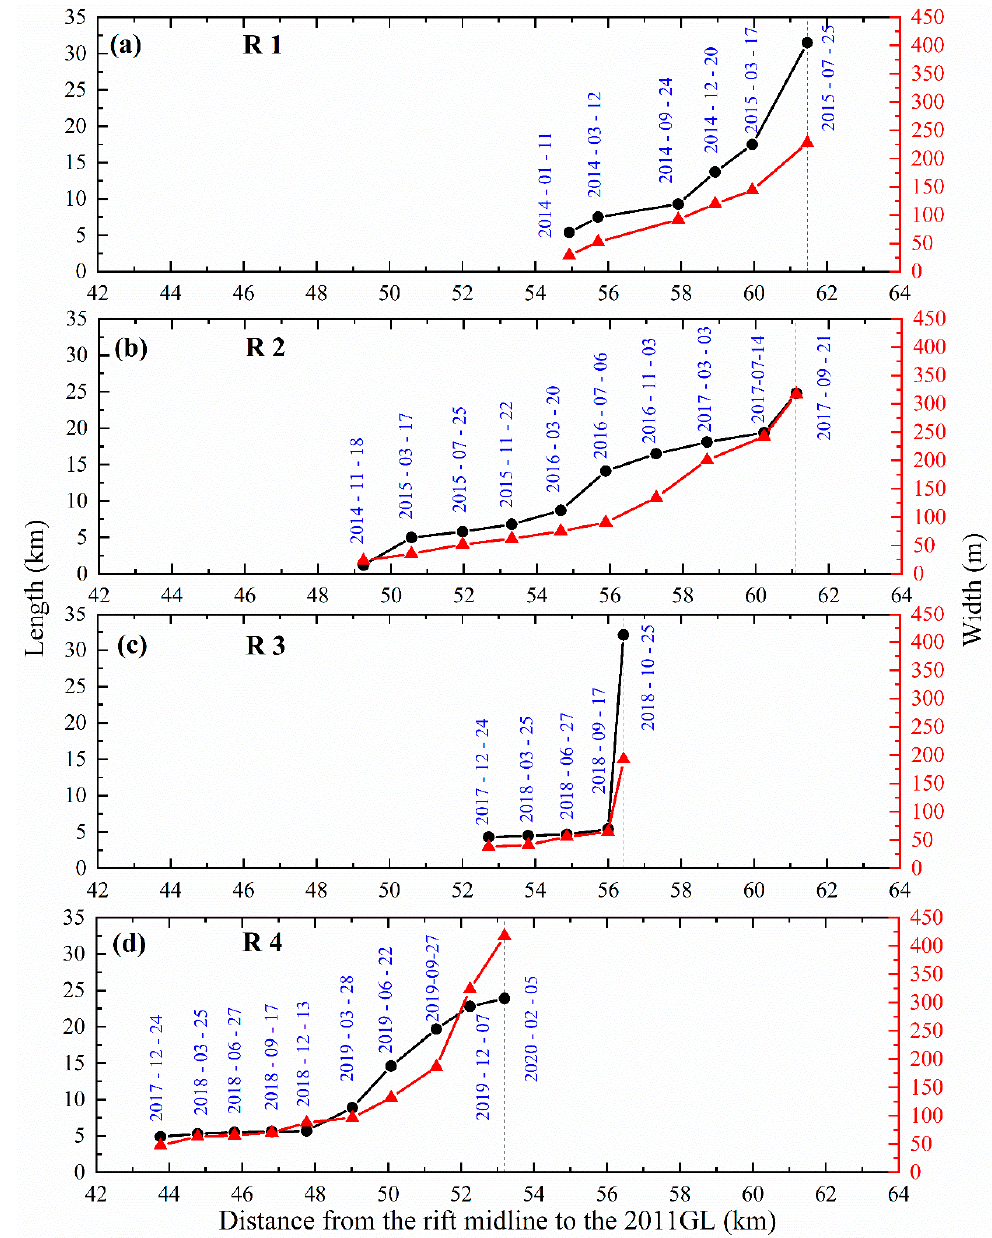
Figure 6. Times series records of four rifts in length and width. ( a ) Changes in length and width of R1, ( b ) changes in length and width of R2, ( c ) changes in length and width of R3, ( d ) changes in length and width of R4. The black dashed lines show the location of the rift right before calving.